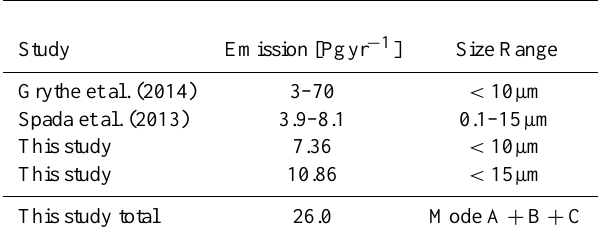
Table 4. Annual sea-salt aerosol emissions obtained within this study compared to ranges given by different reviews of existing sea- salt aerosol source functions.